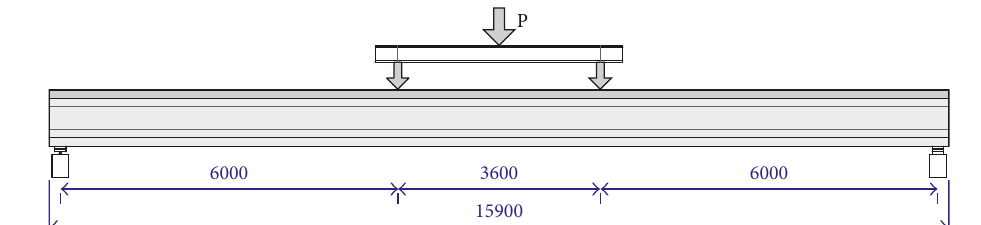
Figure 5: Load pattern for composite girders. Note: all dimensions are in mm.